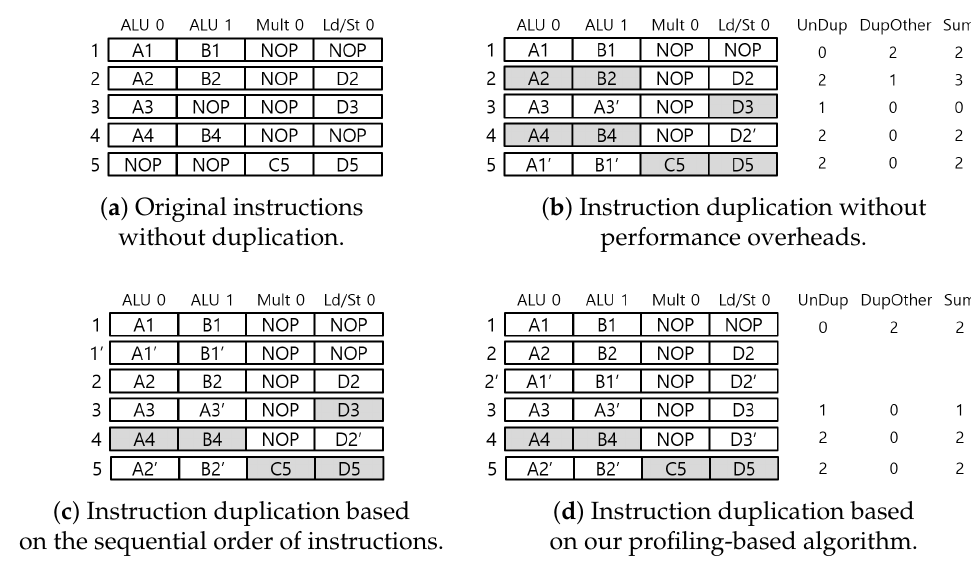
Figure 3. Our profiling-based algorithm can predict the number of duplicable instructions based on the number of unduplicated instructions and duplicated instructions at different